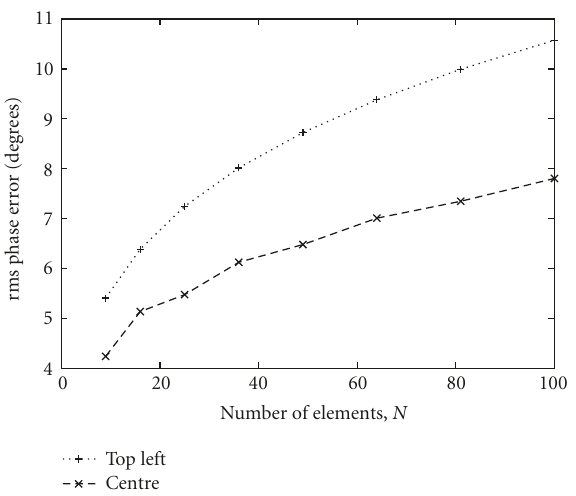
Figure 7: Comparison of the theoretical phase accuracy predicted by the closed form expressions for the square array calibration = 3 ◦ . schemes, with σ c φ